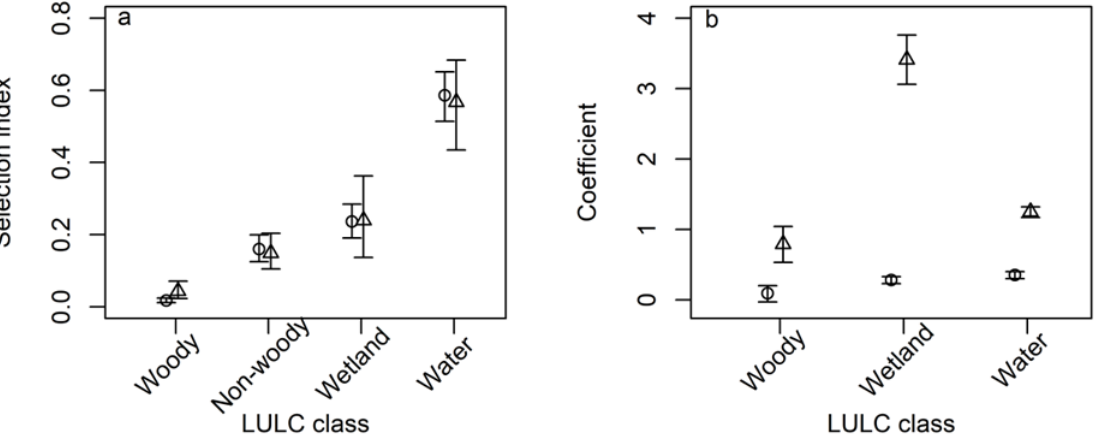
Figure 1. Proportions of six land-use and land cover classes at the breeding ( a ) and non-breeding ( b ) grounds of American white pelicans in the United States.